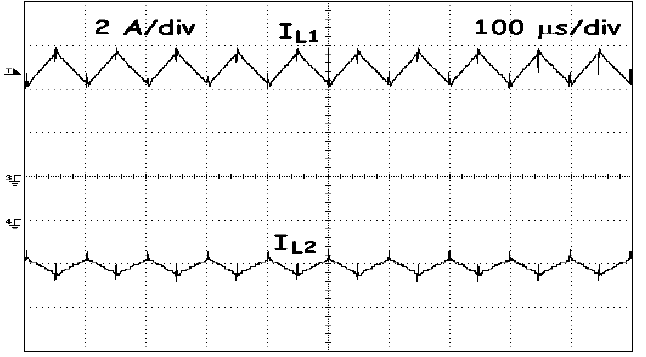
Figure 17. Experimental results for the L 1 and L 2 inductor currents in buck mode.